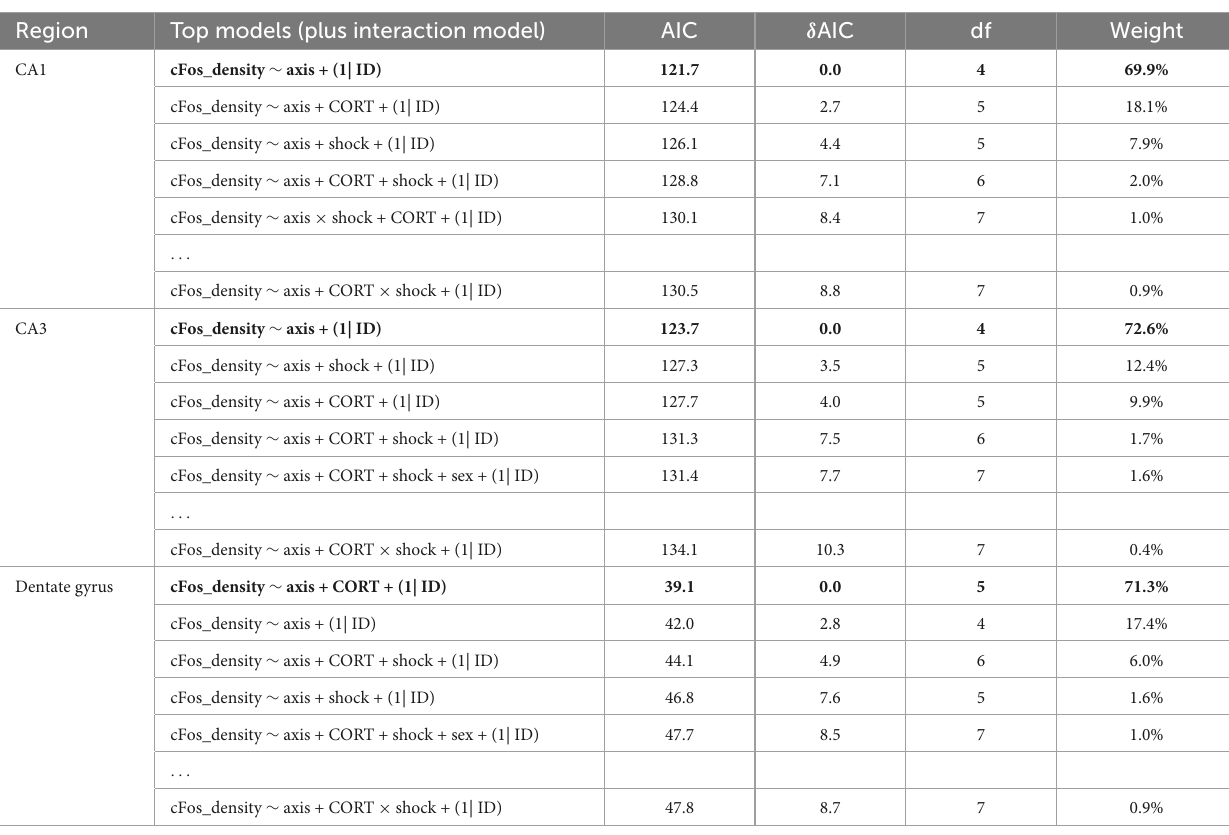
Linear mixed models using different combinations of predictors and controlling for individual variation (ID) were fit for each of the three hippocampal brain regions separately. For each region, the top five models are displayed, in addition to the interaction model (which reliably fit the data poorly). Lower AIC values indicate better fitting models, with the top model in each